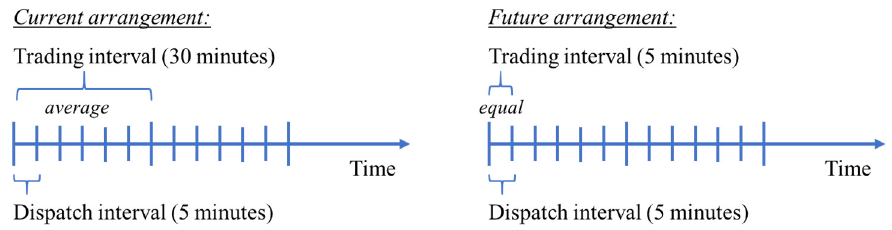
Figure 2. AEMO trading and dispatch intervals before (current arrangement) and after (future arrangement) the change to 5-min trading intervals.